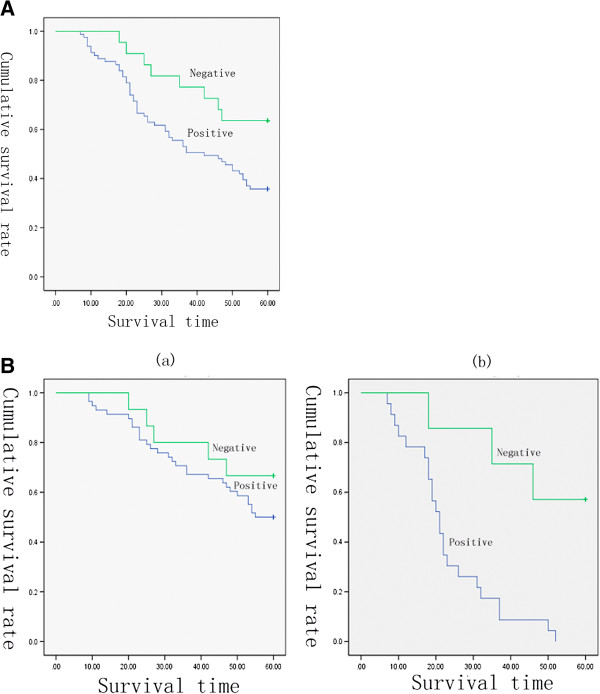
Kaplan-Meier survival curves for postoperational gastric cancer patients. (A) Kaplan-Meier survival curves in patients after gastrectomy according to FOXM1 expression (n = 103) (P =0.030). (B) Survival curves for the 103 gastric cancer patients with different tumor size according to FOXM1 expression. (a) Survival curves for the 73 patients with tumor size ≤ 5 cm according to FOXM1 expression (P = 0.294). (b) Survival curves for the 30 patients with size of tumor > 5 cm according to FOXM1 expression (P = 0.004).